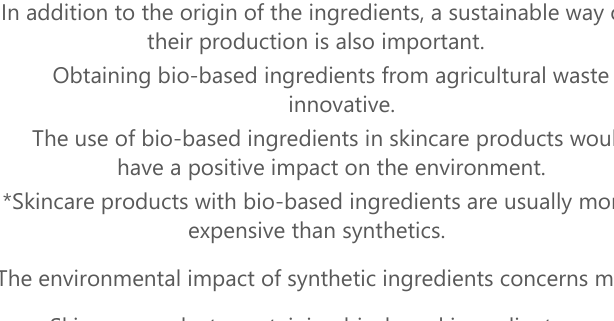
Figure 7. Sum of the ranked properties of sunscreen from most to least important.